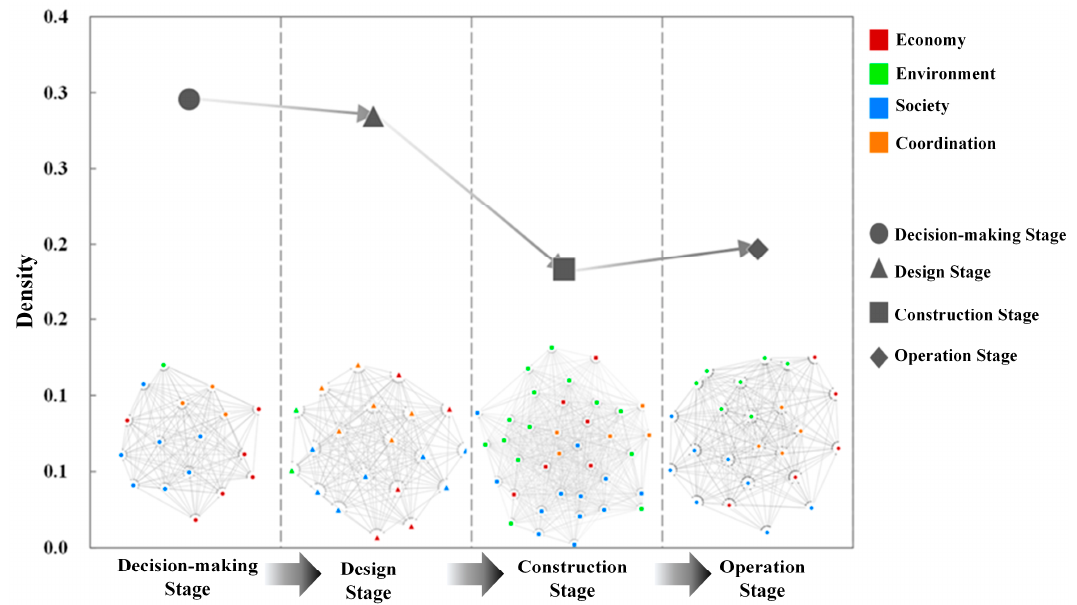
Figure 2. Four stage risk networks and the evolution of network density.